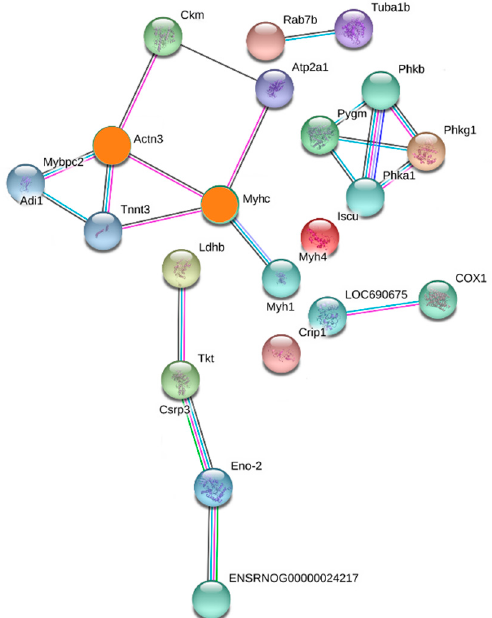
Figure 5. Proteins in the PPI network between SDG and MG groups. The most enriched two node proteins (marked with orange color) with high connectivity degree interacting with four significantly expressed proteins.